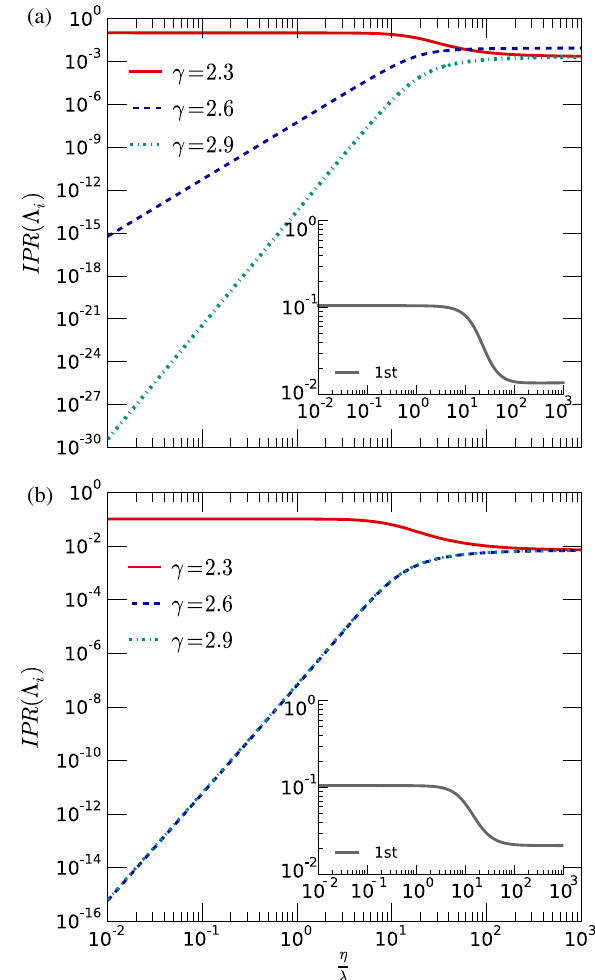
FIG. 8. Spectral properties of the tensor R ð λ ; η Þ as a function of the ratio η = λ for a multiplex with two layers with the same degree distribution (different random realizations of the configuration model) and connected to its counterpart on the other layer. In the top panel, we present the IPR ð Λ Þ of the two larger eigenvalues and the individual-layer contributions, while in the bottom panel, we show the leading eigenvalues. Every curve is composed by 10 3 log spaced points, in order to have enough resolution. In panel (a), we show the line ð 2 . 3 þ 2 . 9 þ 2 . 6 Þ , while panel (b) is the multiplex